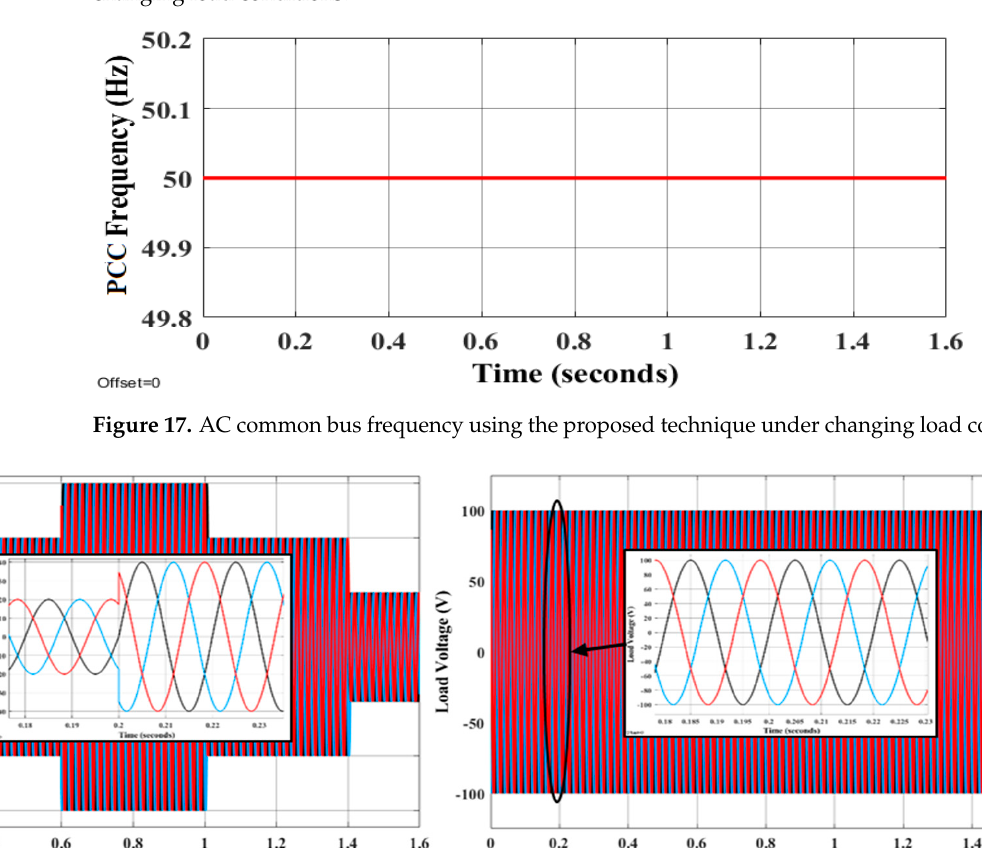
Figure 16. Active and reactive net power flows to the grid using the proposed technique under changing load conditions.